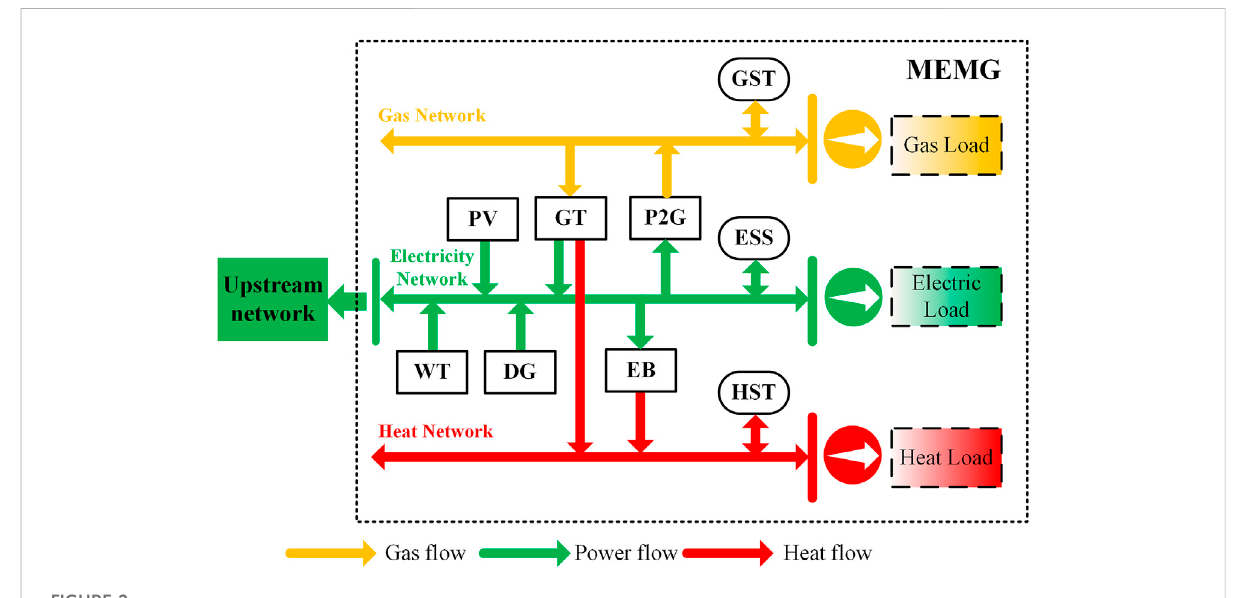
FIGURE 2 Typical MEMG structure incorporated with multiple